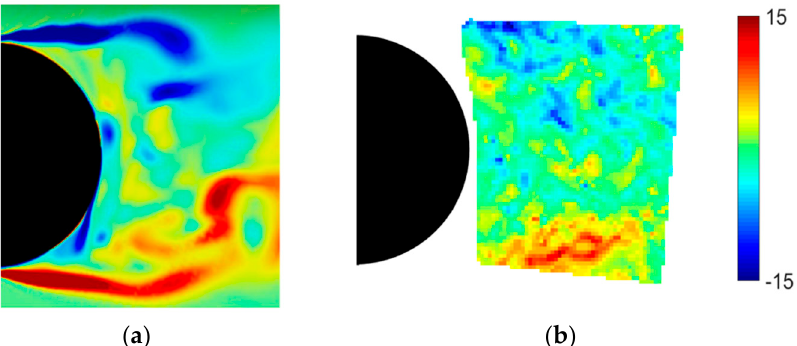
Figure 9. Normalized instantaneous spanwise vorticity (cid:101) ω z = ω z / ( U ∞ D ) ( a ) Simulation, ( b ) Experiment.